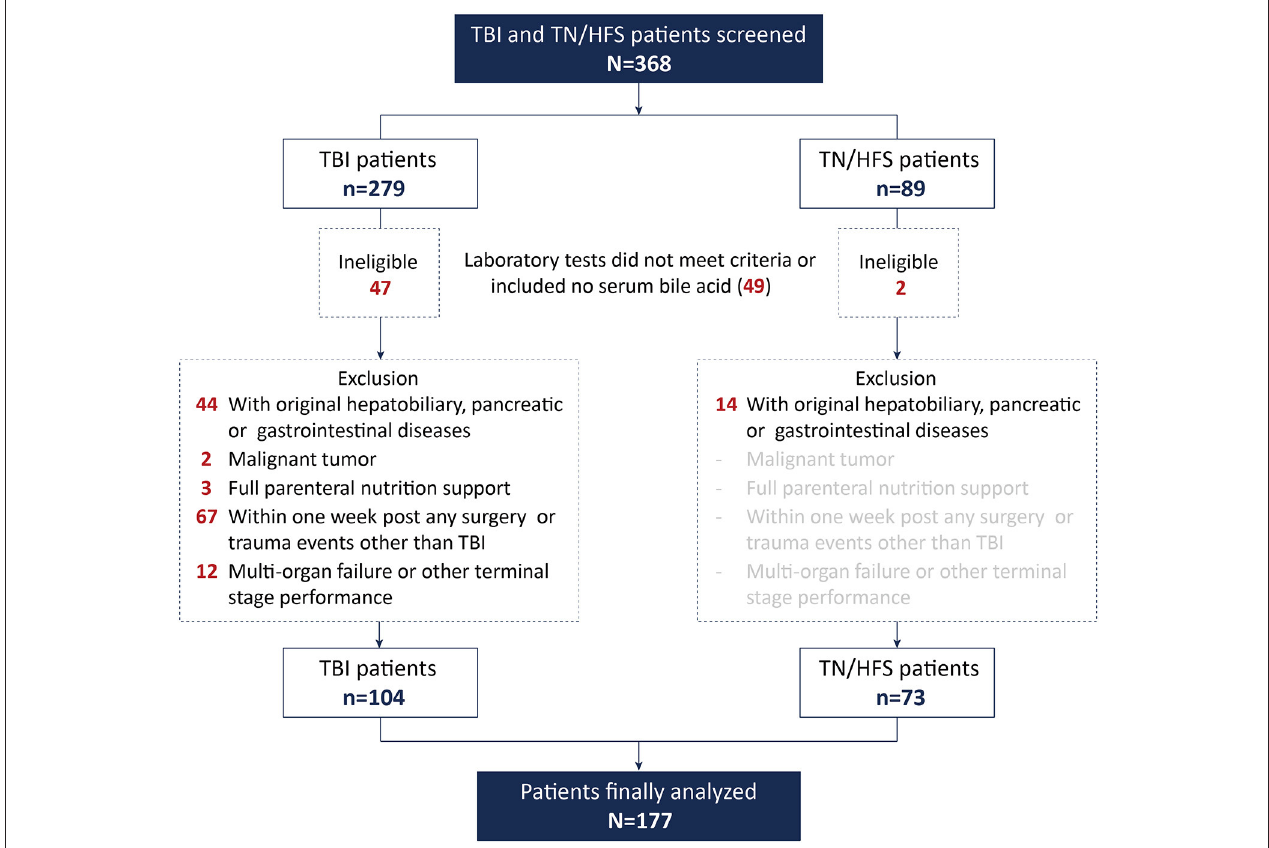
FIGURE 1 | Details of patient inclusion.